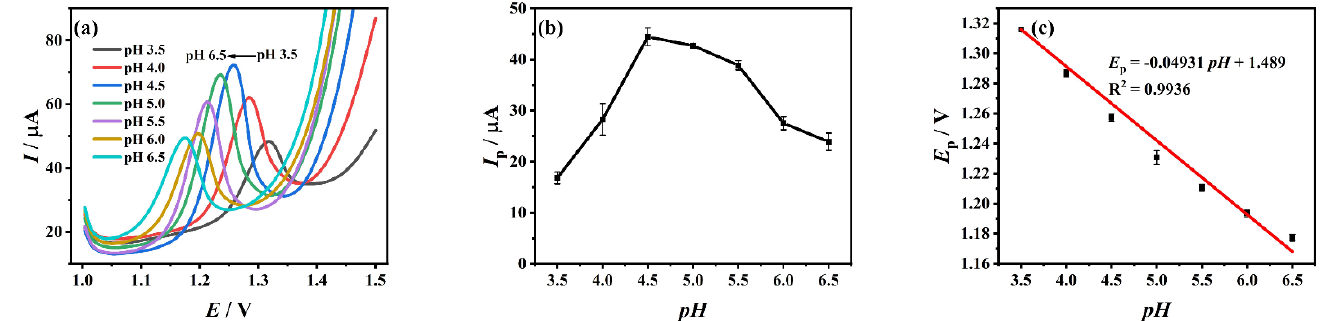
Figure 4. Differential pulse voltammetry (DPV) diagrams ( a ), current response ( b ) and the rela- tionship diagram between peak potential and pH ( c ) of Tenofovir disoproxil fumarate (TDF) on ZrO 2 − CS − MWCNTs/GCE at different pH values.